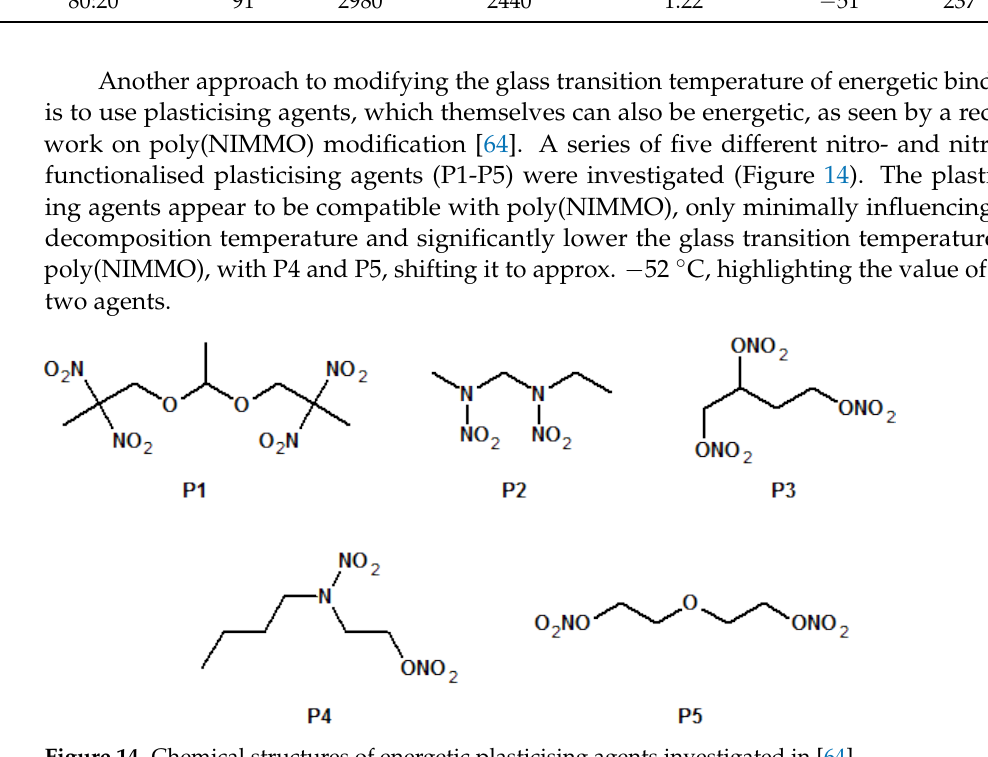
Figure 14. Chemical structures of energetic plasticising agents investigated in